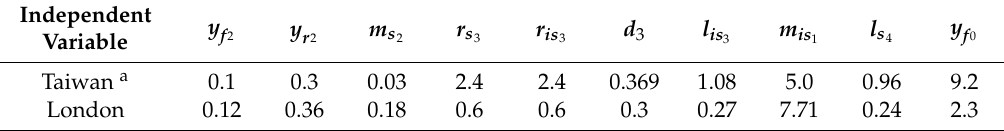
Table 1. The di ff erent parameters between the Taiwan and London security markets.